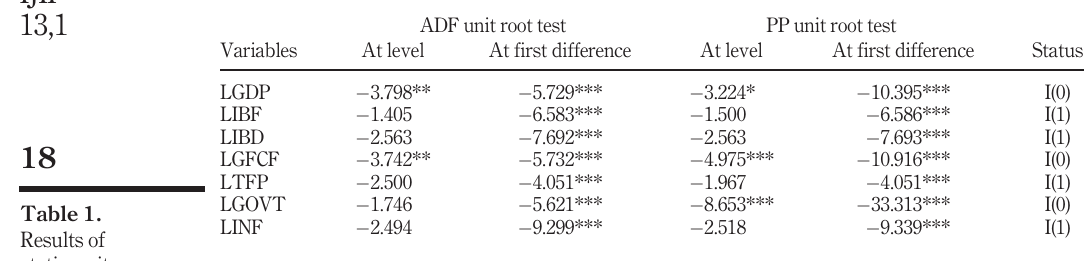
Table 1. Results of stationarity (unit root)